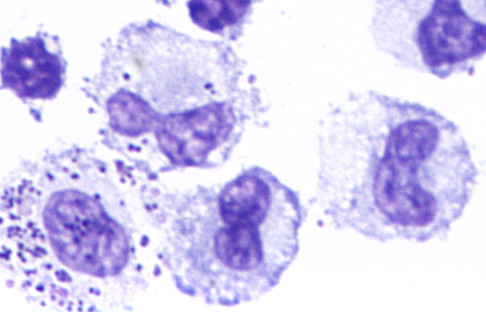
Toluidine blue stain of cytopreparation of HMC-1 cells. Relatively few blue granules were detected in the cultured human mast cell line, suggesting that the cultured mast cell line produced only small amounts of heparin.